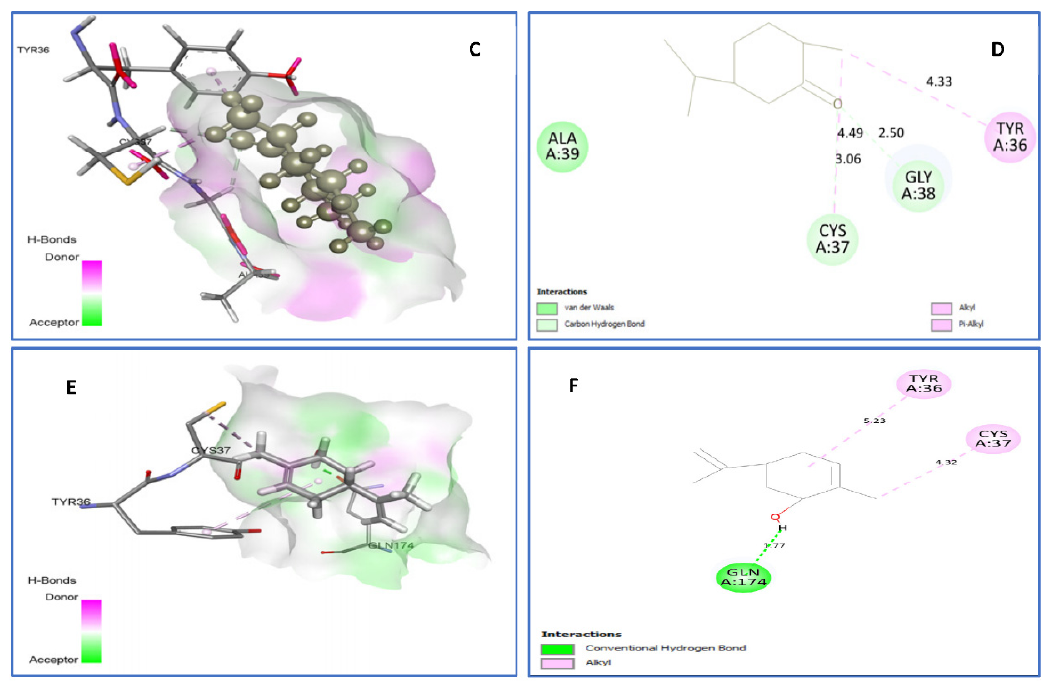
Figure 5. Two-dimensional (2D) and three-dimensional (3D) residual interactions network of eugenol ( A , B ), trans -dihydrocarvone ( C , D ), and trans -carveol ( E , F ) with the active site of tyrosyl-tRNA synthetase (PDB Id: 1JIJ) enzyme.